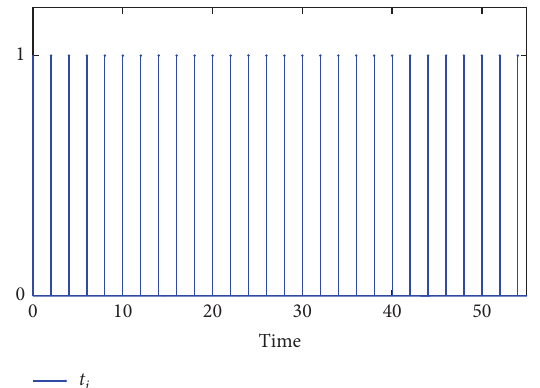
Figure 8: The starting instant of each control of the observer-based PIC.